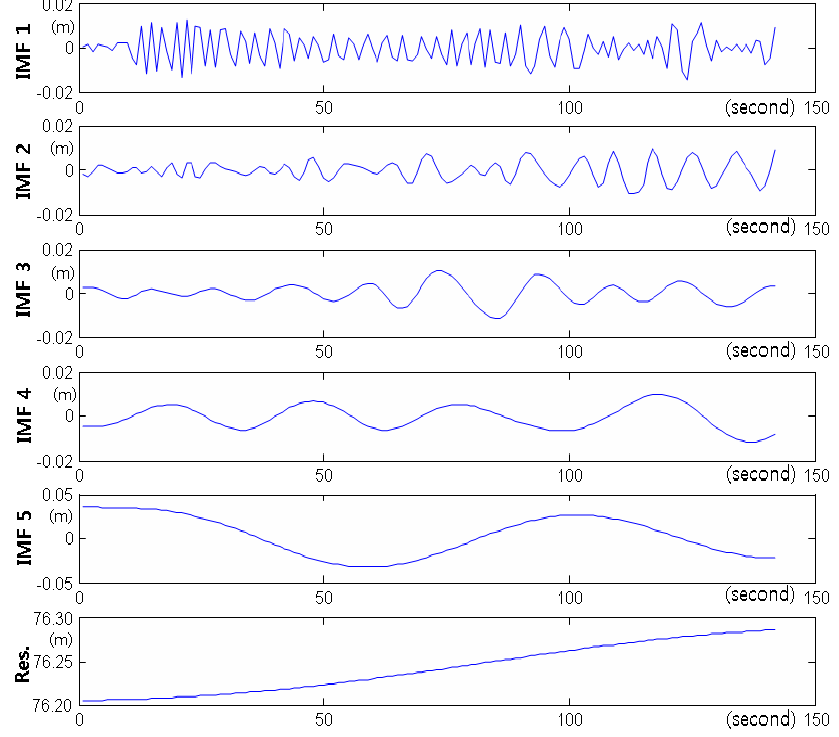
Figure 16. RTK-GPS measurements decomposed by frequency using the EMD